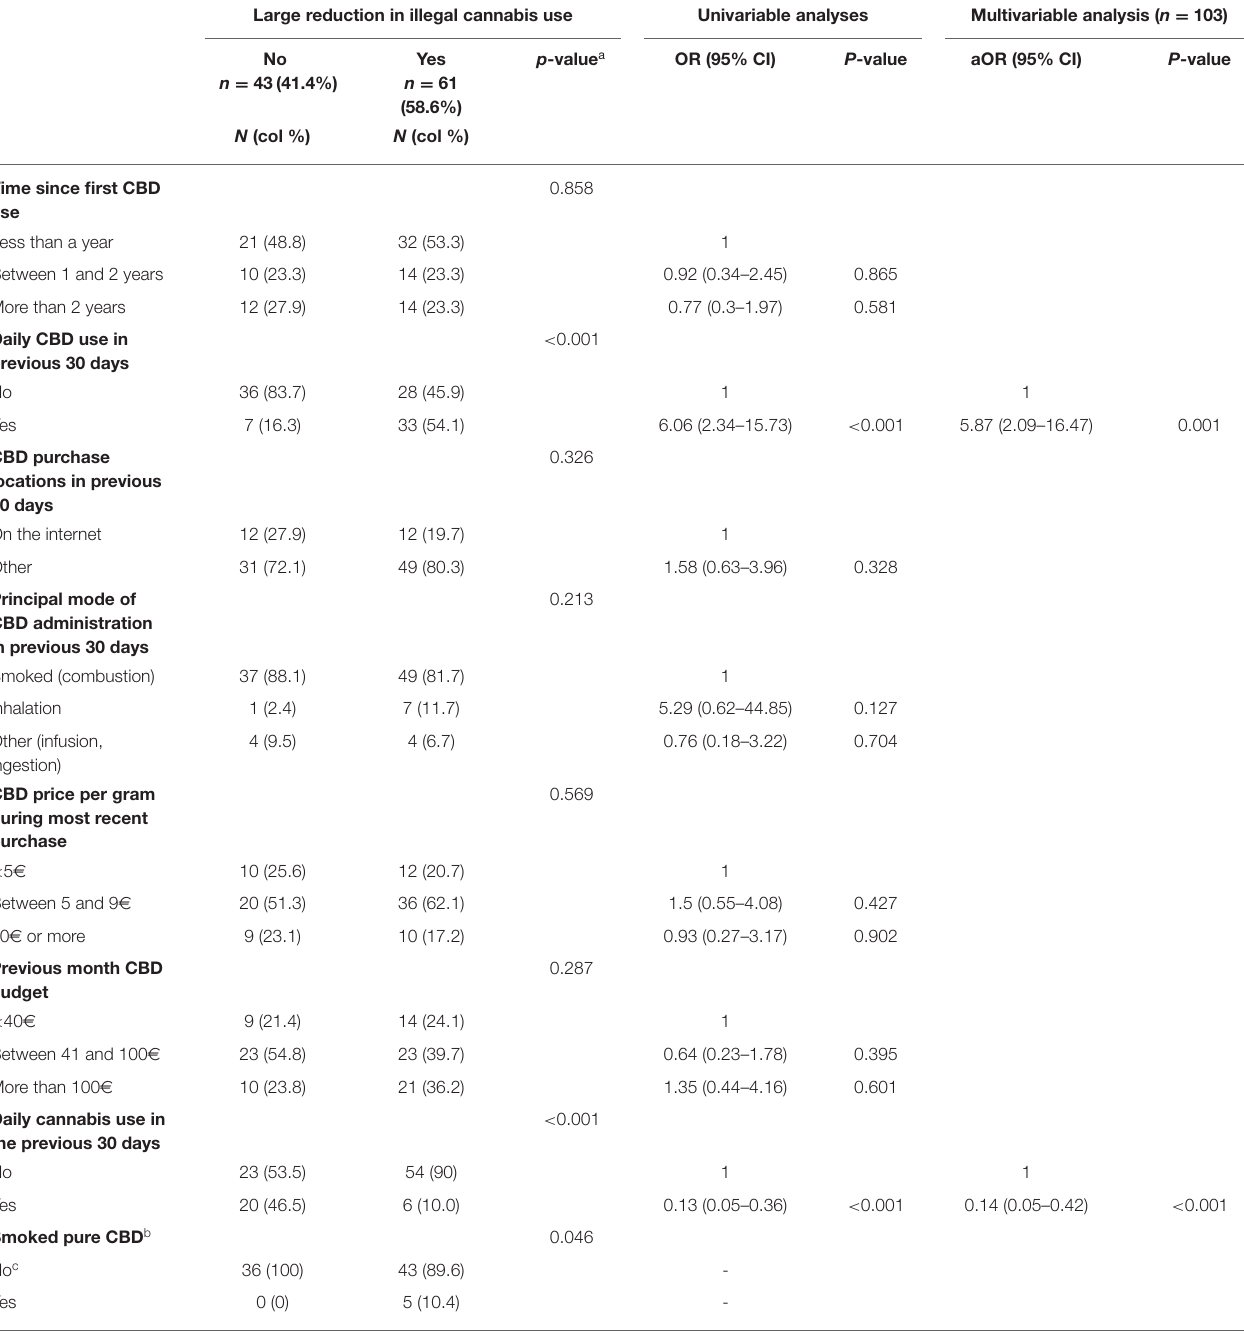
TABLE 2 | Cannabidiol products pattern of use among users who used cannabidiol to reduce illegal cannabis consumption, and factors associated with a large reduction in illegal cannabis consumption. Large reduction in illegal cannabis use Univariable